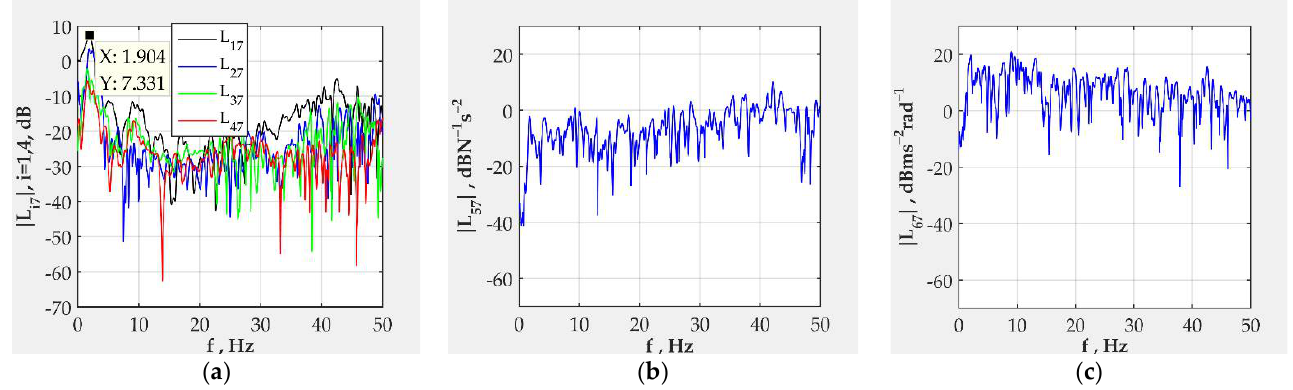
Figure 11. Magnitudes of optimal frequency response functions for the transfer channels: ( a )